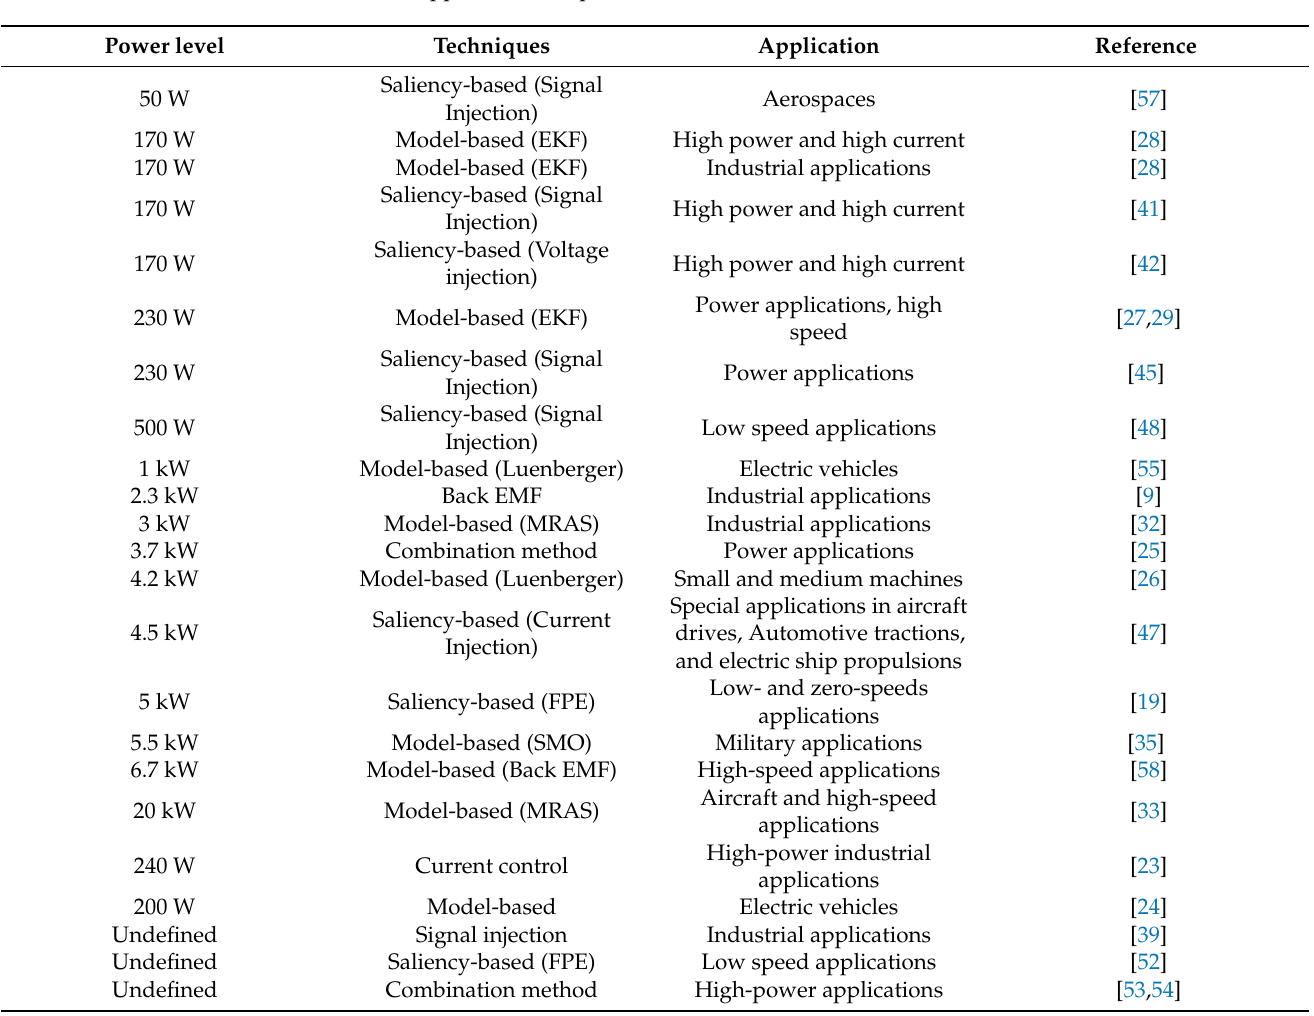
Table 4. Application and power levels of sensorless control of